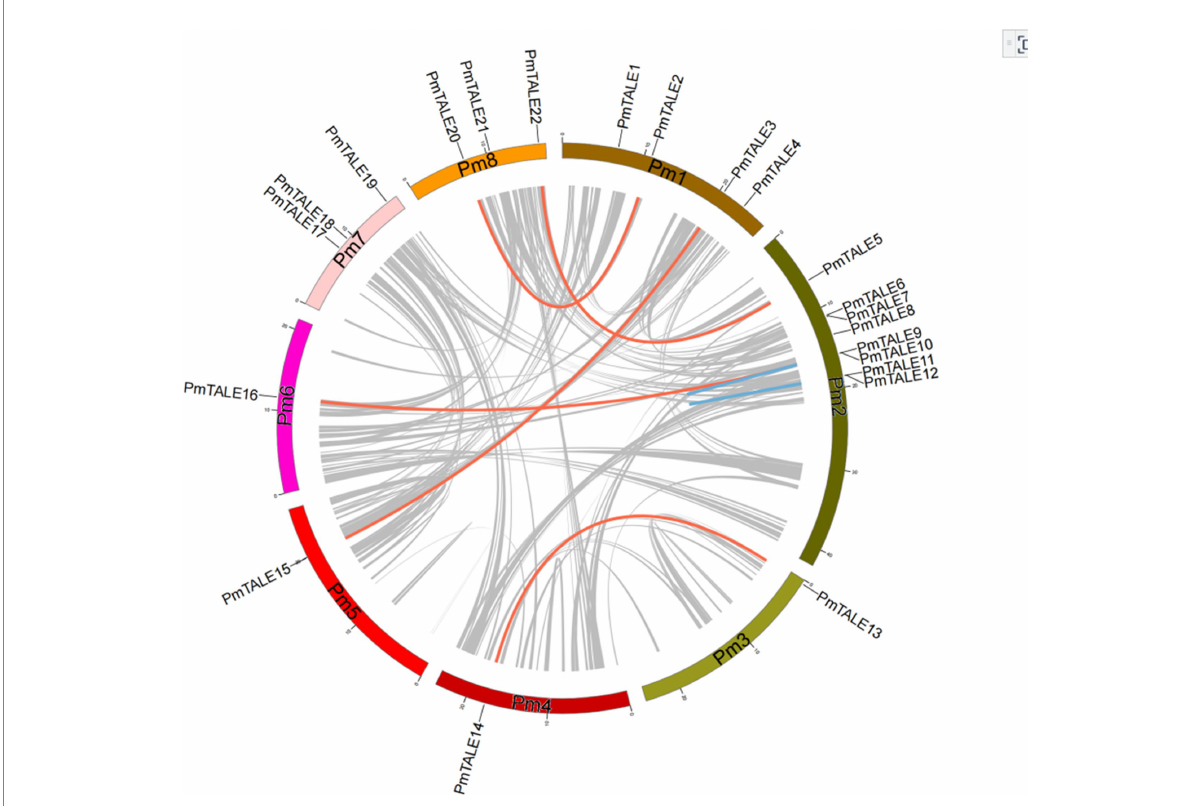
FIGURE 7 Intra species collinearity analysis of Prunus mume TALE gene family. Red lines indicate gene pairs that form genome-wide replication (WGD) or segmental duplications, blue lines indicate gene pairs that form tandem duplications, and grey lines represent other collinear gene pairs of non- TALE gene family members within the genome.